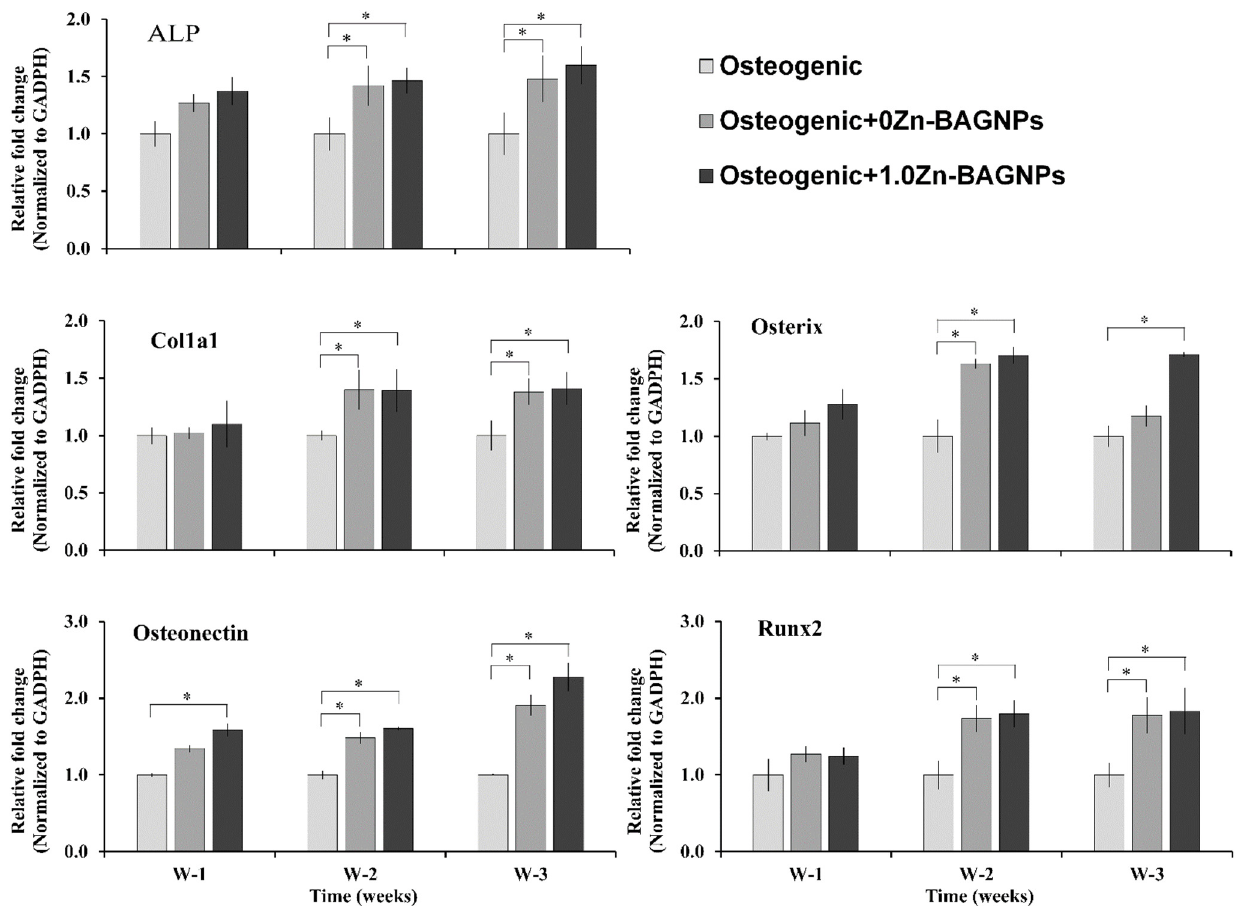
Figure 12. Quantitative real-time reverse transcriptase PCR analysis showing the expression of os- teogenic marker genes in PDLSCs treated with Zn-BAGNPs, cultured under the osteogenic condition for 1 week, 2 weeks, and 3 weeks. Gene expression was normalized to GAPDH (a housekeeping gene) transcript levels. The data represent two independent experiments. The values are the mean ± SD ( n = 3). The expression of osteogenic marker genes was significantly up-regulated in cells treated with particles compared to untreated cells. * above the bars represents a significant difference between treated PDLSCs versus untreated PDLSCs under the osteogenic condition at the same time interval (* p < 0.05).